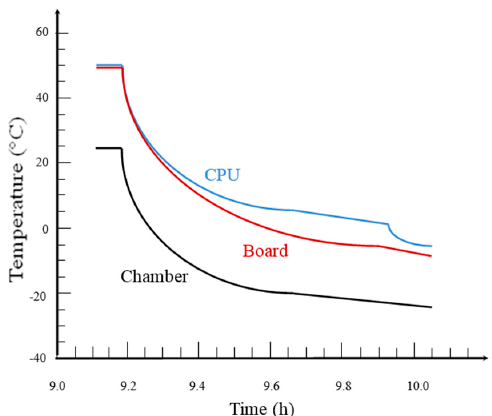
Figure 10. Temperature of climate chamber, CPU and board.